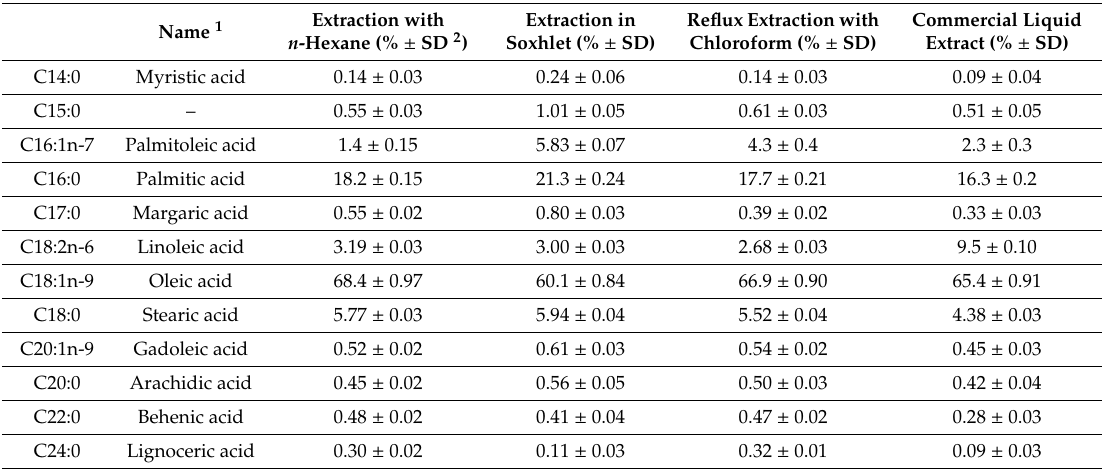
Table 2. Fatty acids composition (percentage of FAMEs) contained in samples of Ganoderma lucidum obtained with di ff erent extraction